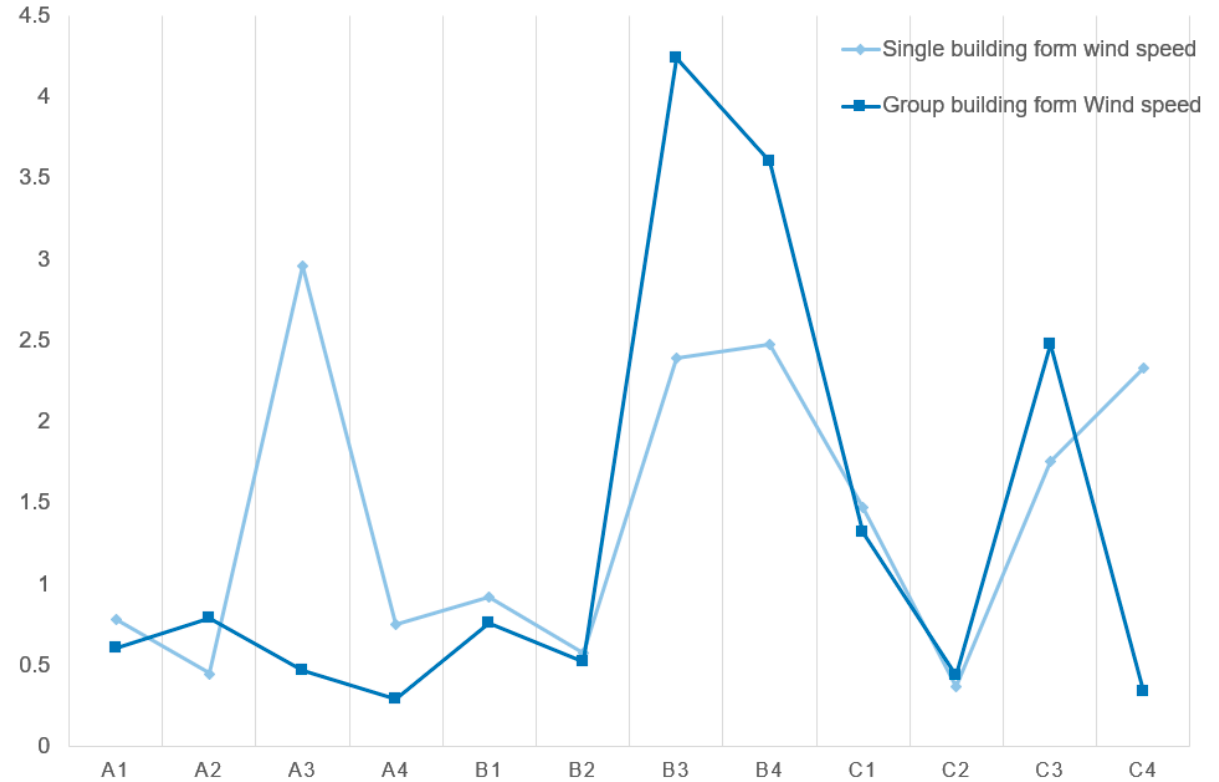
Figure 8. Comparison of wind speed at the same point between swarm simulation and individual simulation.